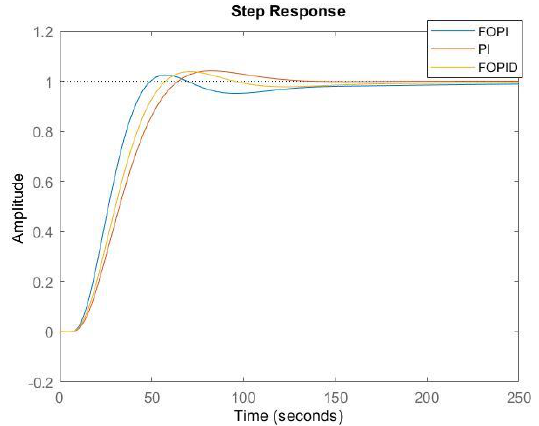
Figure 15. Step responses of closed-loop system for the integer-order PI, FO-PI, and FO-PID con- trollers in the case of −2% process changes.